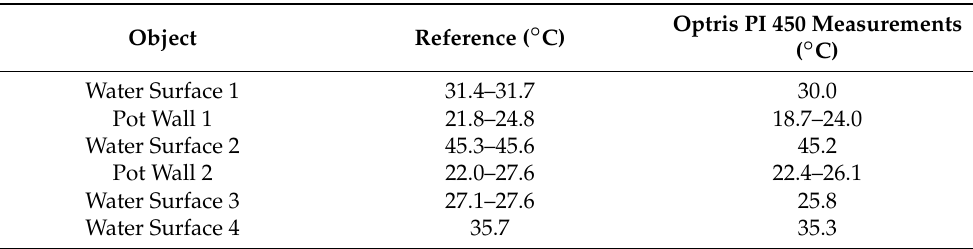
Table 4. Object temperatures during the test run were measured by the thermal camera Optris PI 450. A non-contact infrared thermometer served as a